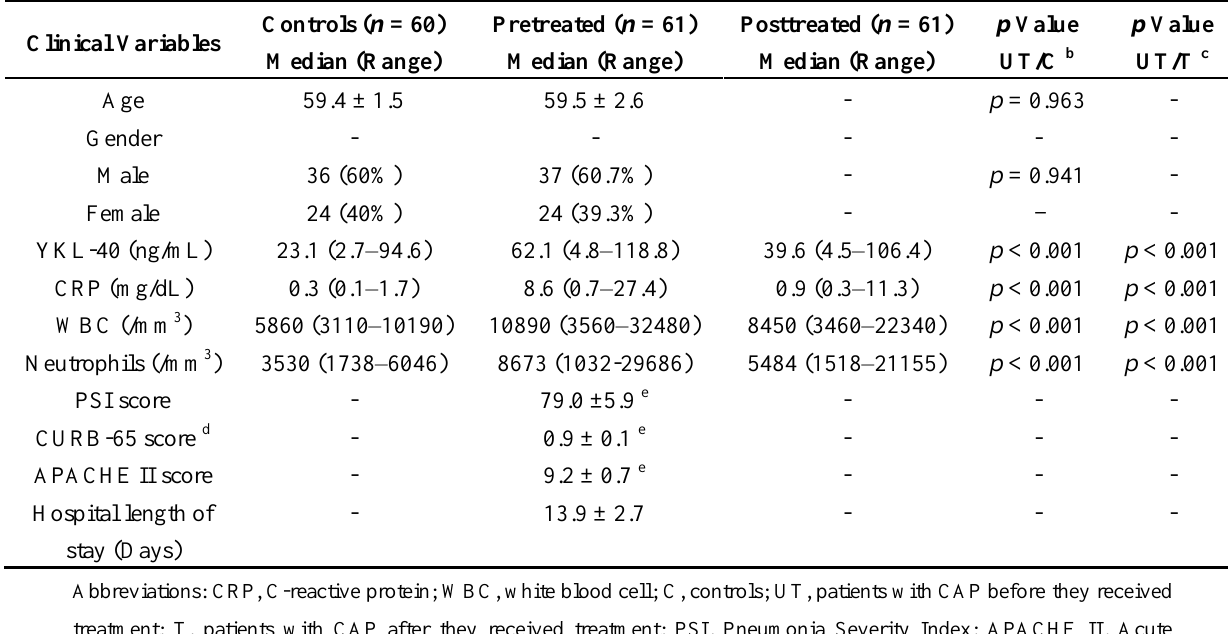
Table 1. The laboratory data of both controls and patients with community-acquired pneumonia (CAP) before and after they received treatment a